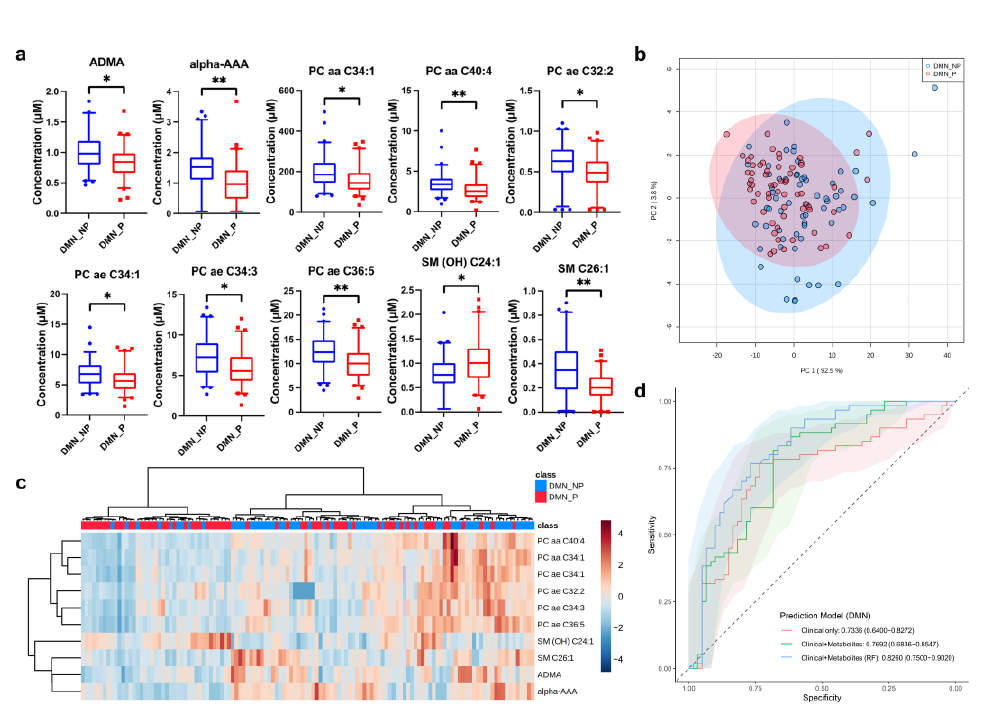
Figure 2. Multivariate statistical analysis and predictive modeling of the selected DMN progression- related biomarkers. ( a ) Individual box-and-whisker plot (median, 5 – 95 percentile) of the selected metabolites in DMN progressors (P, red) and non-progressors (NP, blue). ( b ) PCA of two components of selected metabolites from DMN progressors (P, red) and non-progressors (NP, blue). ( c ) Heatmap and hierarchical clustering analysis of the selected metabolites from DMN progressors (P, red) and non-progressors (NP, blue). ( d ). ROC curves for three prediction models of DMN progression: models using clinical parameters only (red) or together with selected metabolite biomarkers (green: by logistic regression; blue: by random forest). Solid line: mean AUC of the 5-fold cross-validation. Shaded area: 95% CI of AUC. * q < 0.05, ** q < 0.01. PC aa: diacyl-phosphatidylcholine; PC ae: acyl-alkyl-phosphatidylcholine. Table 2. List of the selected disease progression related biomarkers in each disease group.